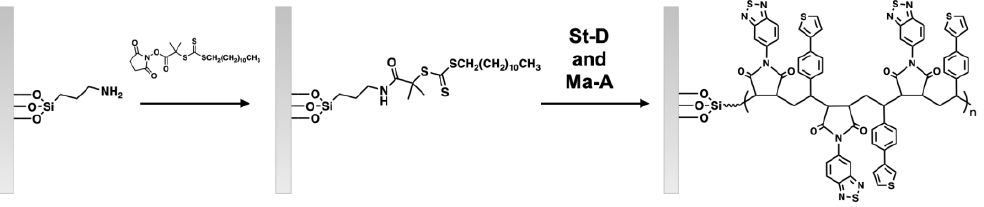
Table 1. Thickness, determined by ellipsometry, and water contact angles of organic layers on silica substrate during the formation of the initiator layer and subsequent RAFT polymerization leading to PB.